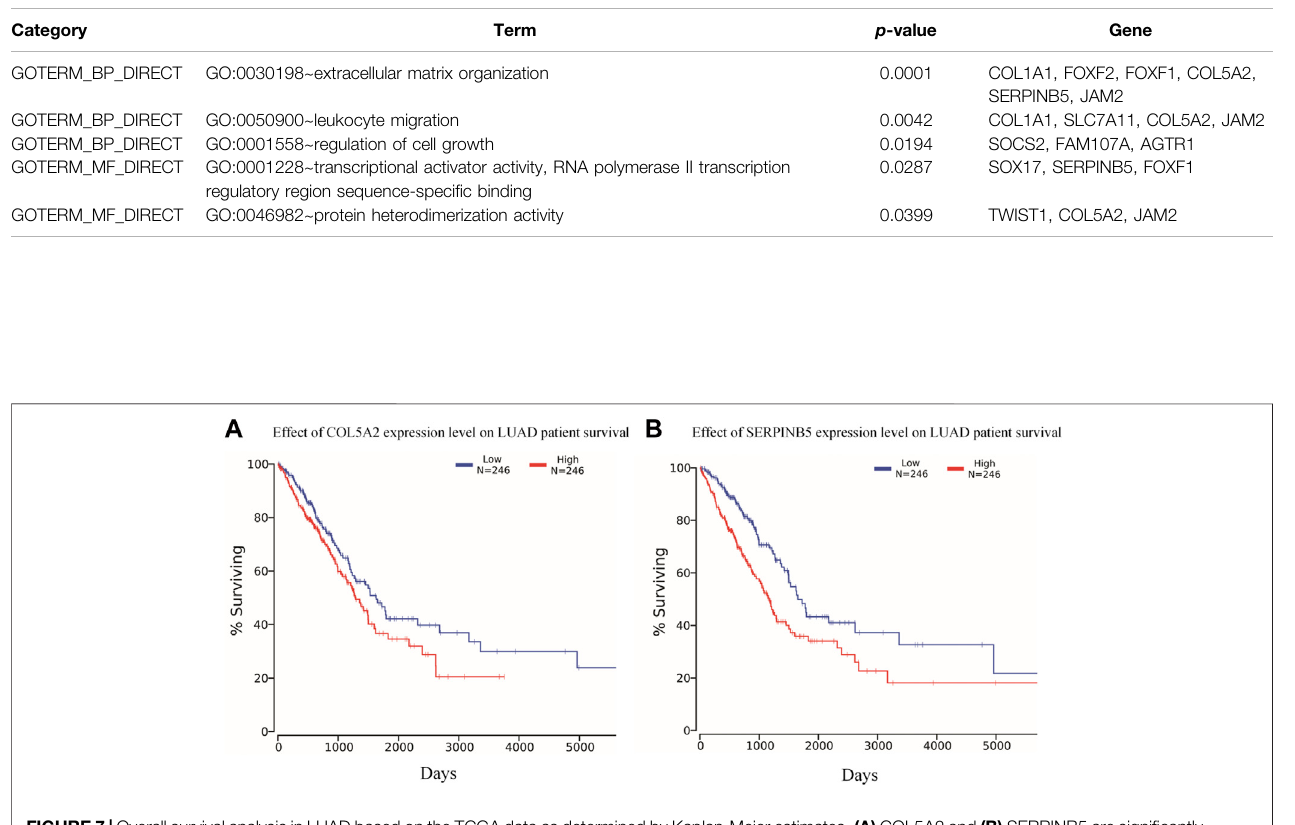
Frontiers in Genetics |